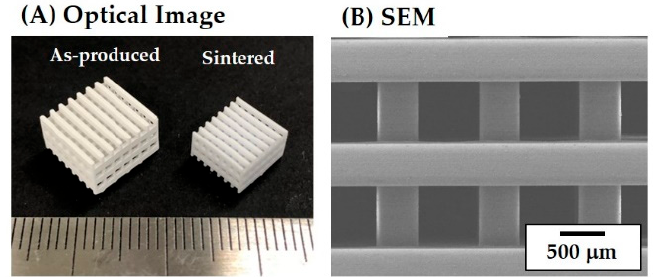
Figure 15. ( A ) Optical image of the as-produced and sintered CaP scaffolds and ( B ) SEM image of the sintered CaP scaffolds (scale in Figure 15A = 1 mm).